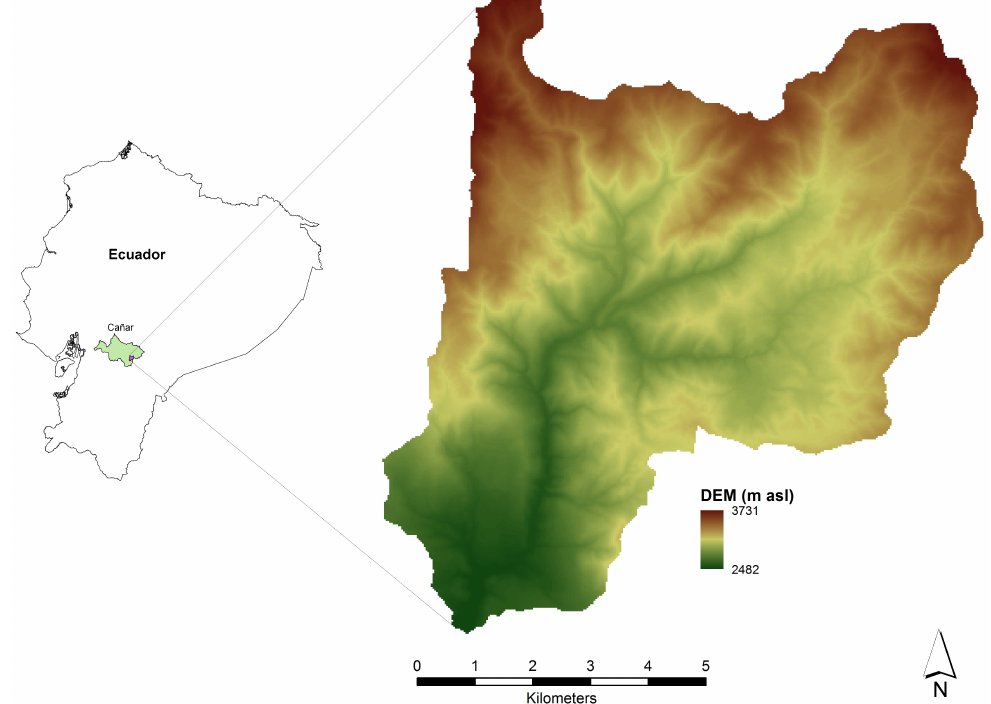
Figure 1. Digital elevation model of the Tabacay River catchment and its location in the province of Cañar in